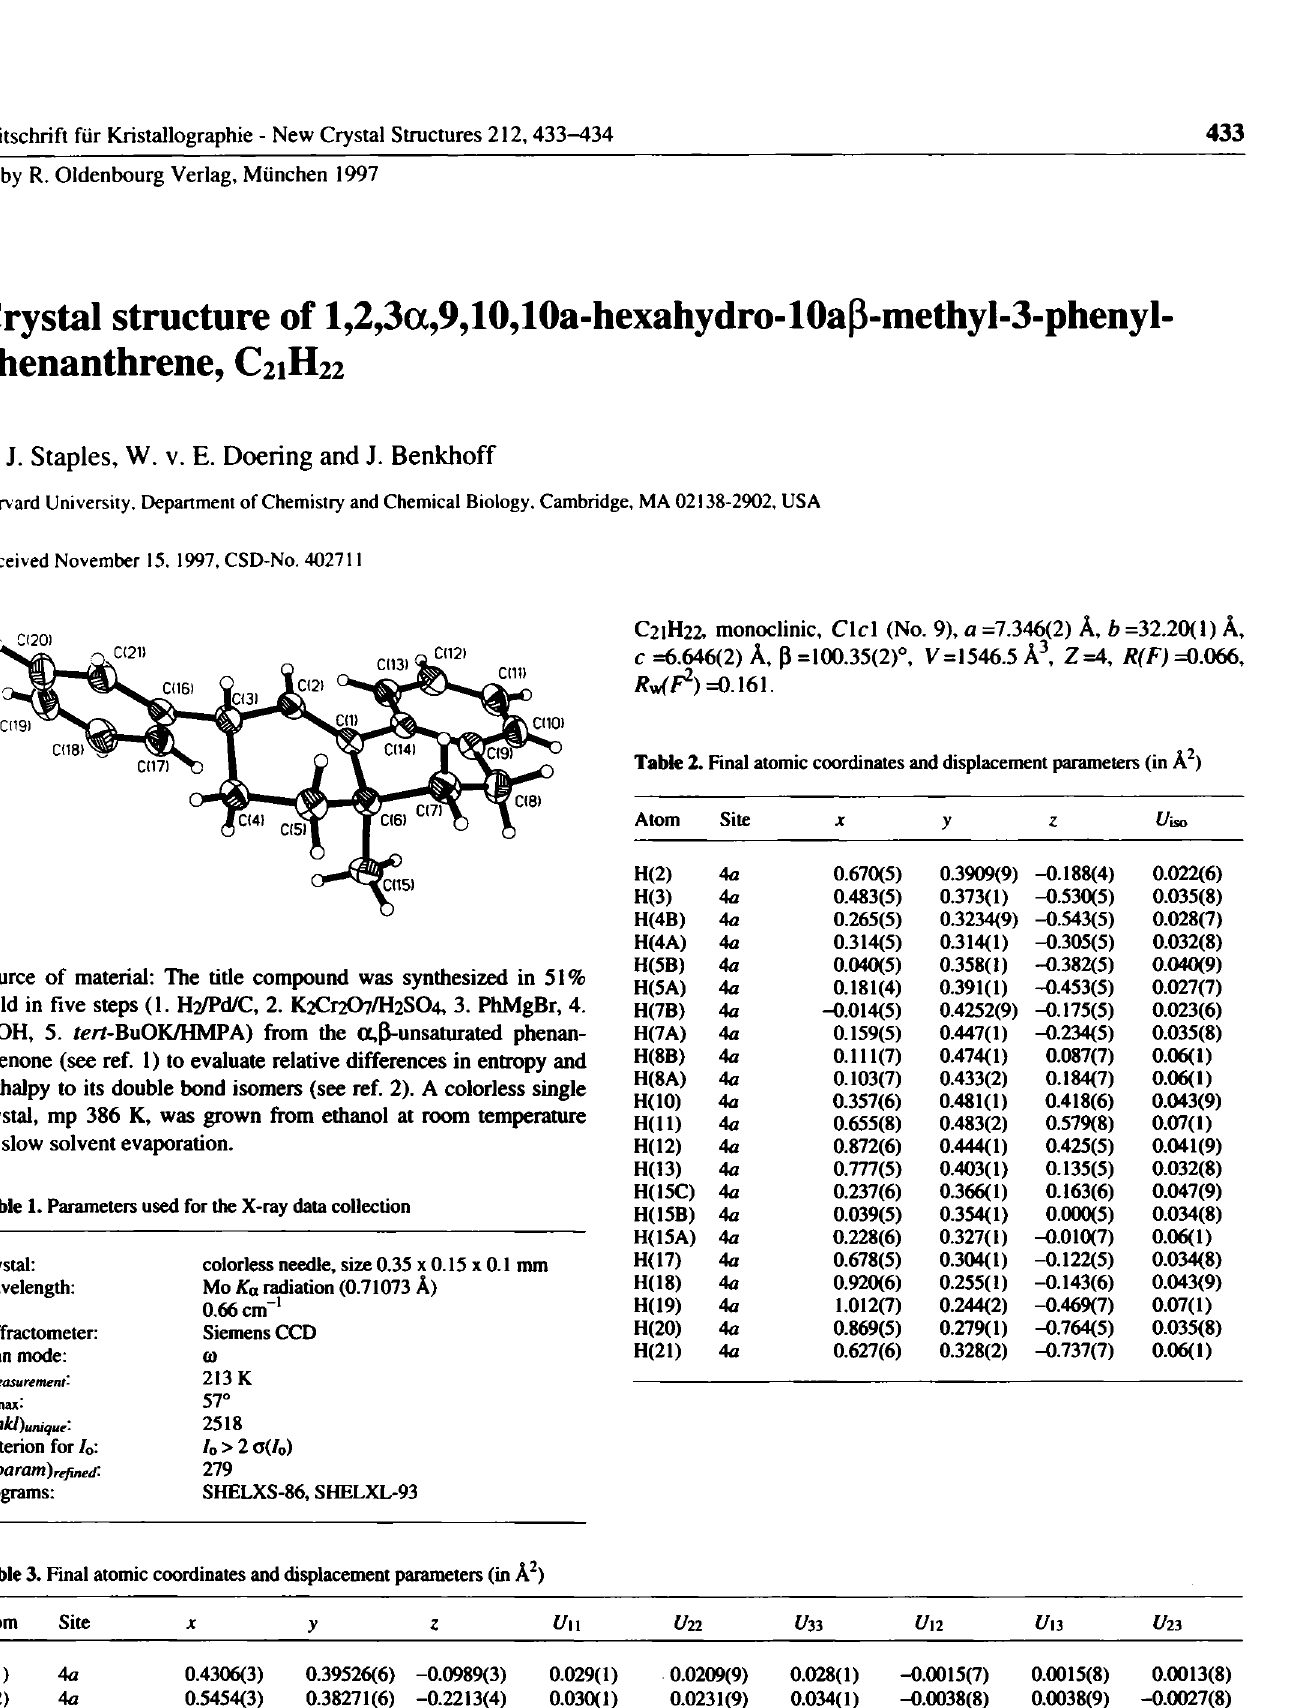
Table 3. Final atomic coordinates and displacement parameters (in Â 2 )